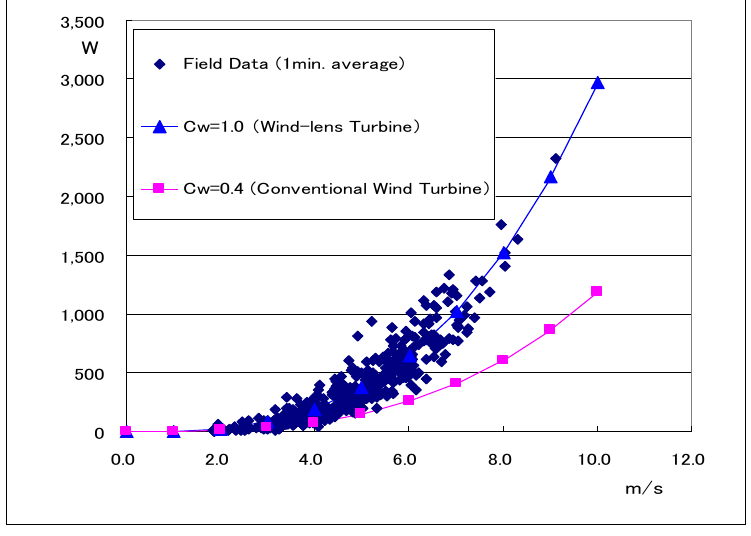
Figure 15 . Field experiment of 5 kW wind-lens turbine. C * = 0.54, based on the brim diameter C w